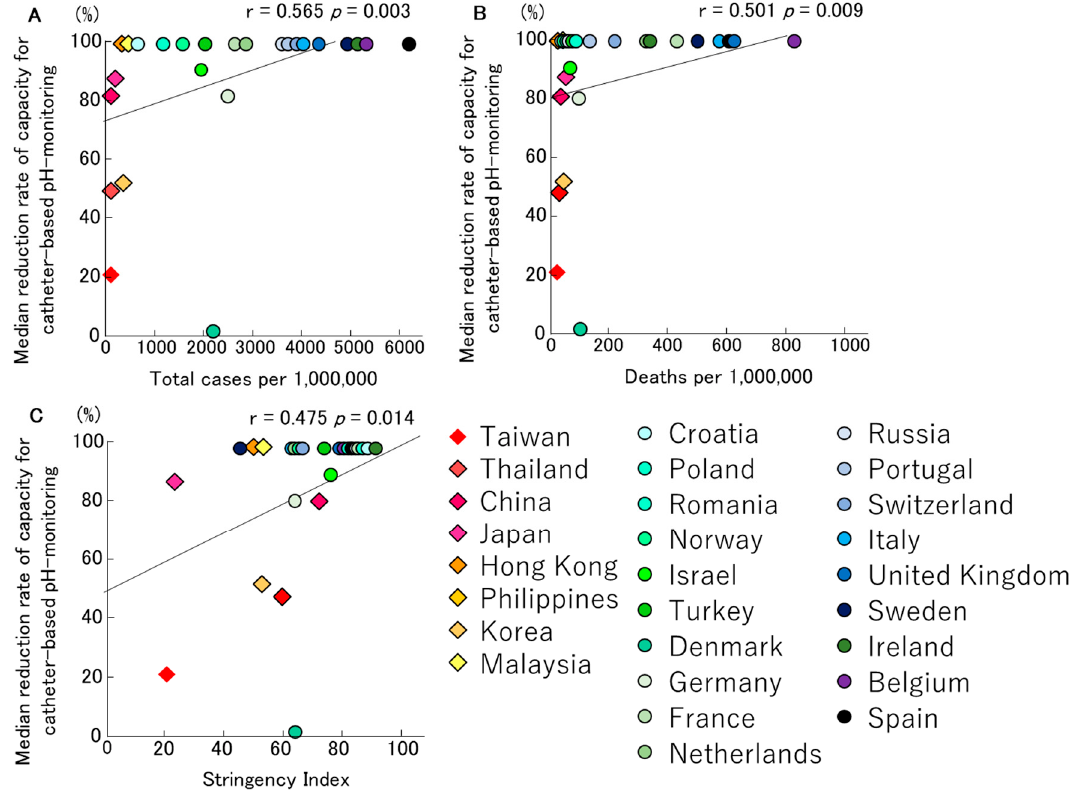
Figure 2. The relationships between median reduction rates of capacity for catheter-based pH monitoring, total infection rate ( A ) / mortality rate ( B ) for COVID-19 and Stringency Index ( C ) in Asian and European countries, are described. There was a significant trend between the infection rates and mortality rates of COVID-19, the Stringency Index and the median reduction rates of catheter-based pH monitoring.